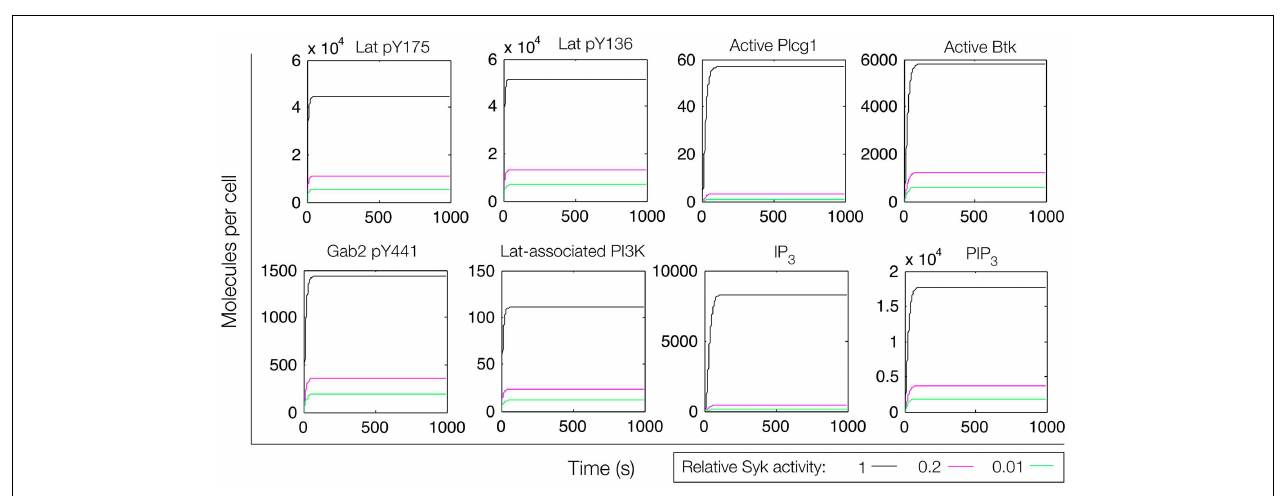
FIGURE 5 | Simulation of a model of the feed-forward loop connecting Lat to IP 3 production . Different color lines indicate different relative levels of Syk activity. In these simulations, Syk activity was set at the indicated level and held